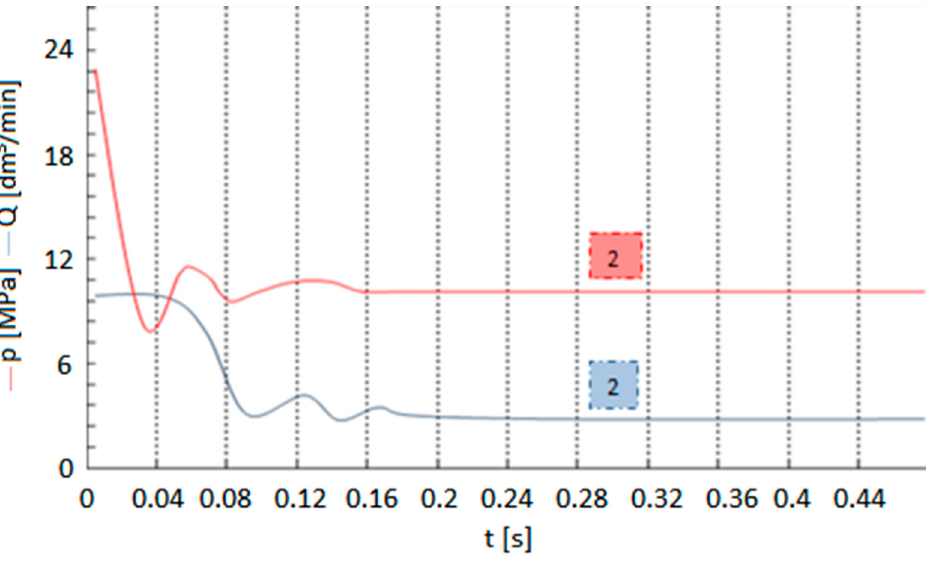
In the system of multi-valued logic functions with weighting factors, weighting factors are assigned separately for each of the functions. Figures 9–13 show the time periods of the Q and p functions with the weighting factor intervals marked w i : p (red color) and Q (blue color).